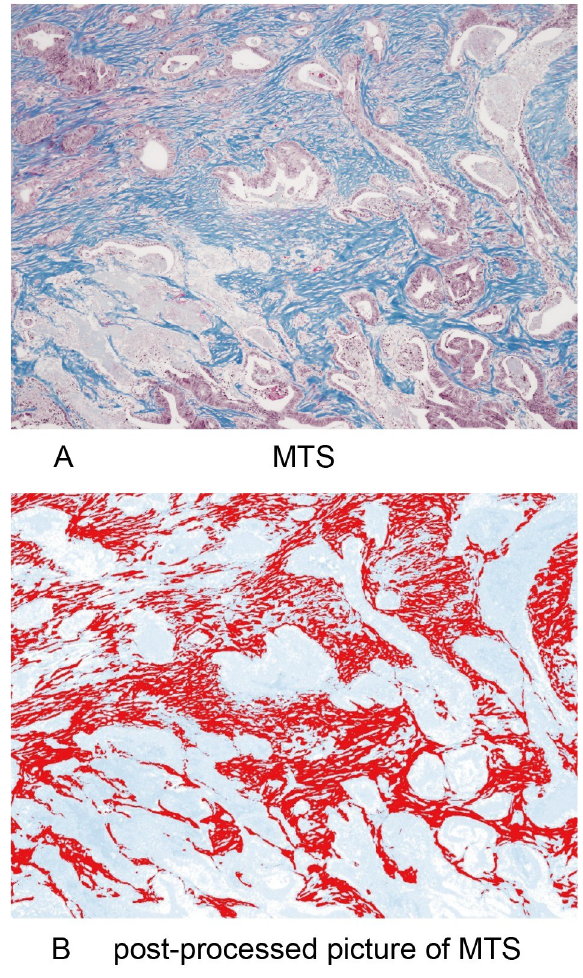
Fig 2. Original and post-processed images of Masson’s trichrome staining. (A) Collagen fibers stained blue on Masson’s trichrome staining at x40 HPF. (B) A post-processed image in which the blue area of collagen fibers was changed to a red color using